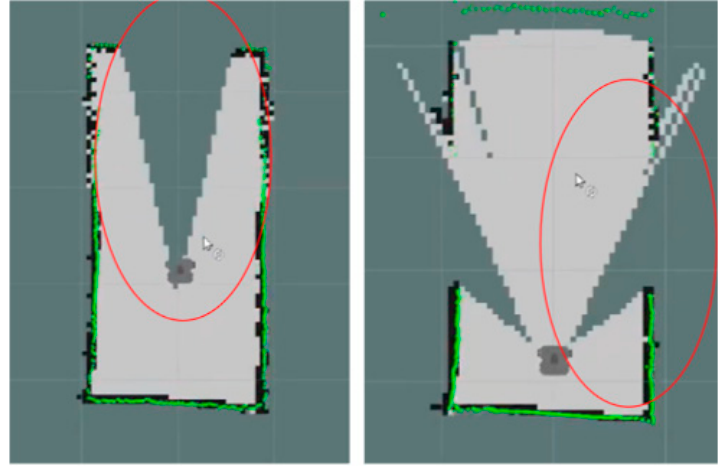
Figure 13. Observation of negative space in mirrored environments. Negative spaces are shown with red ovals.